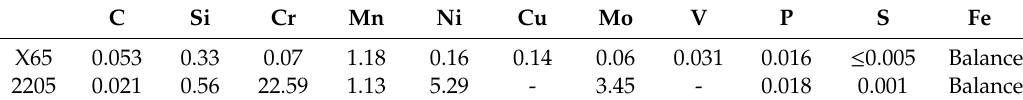
Table 2. Chemical composition of X65 pipe steel and 2205 duplex stainless steel (wt %).